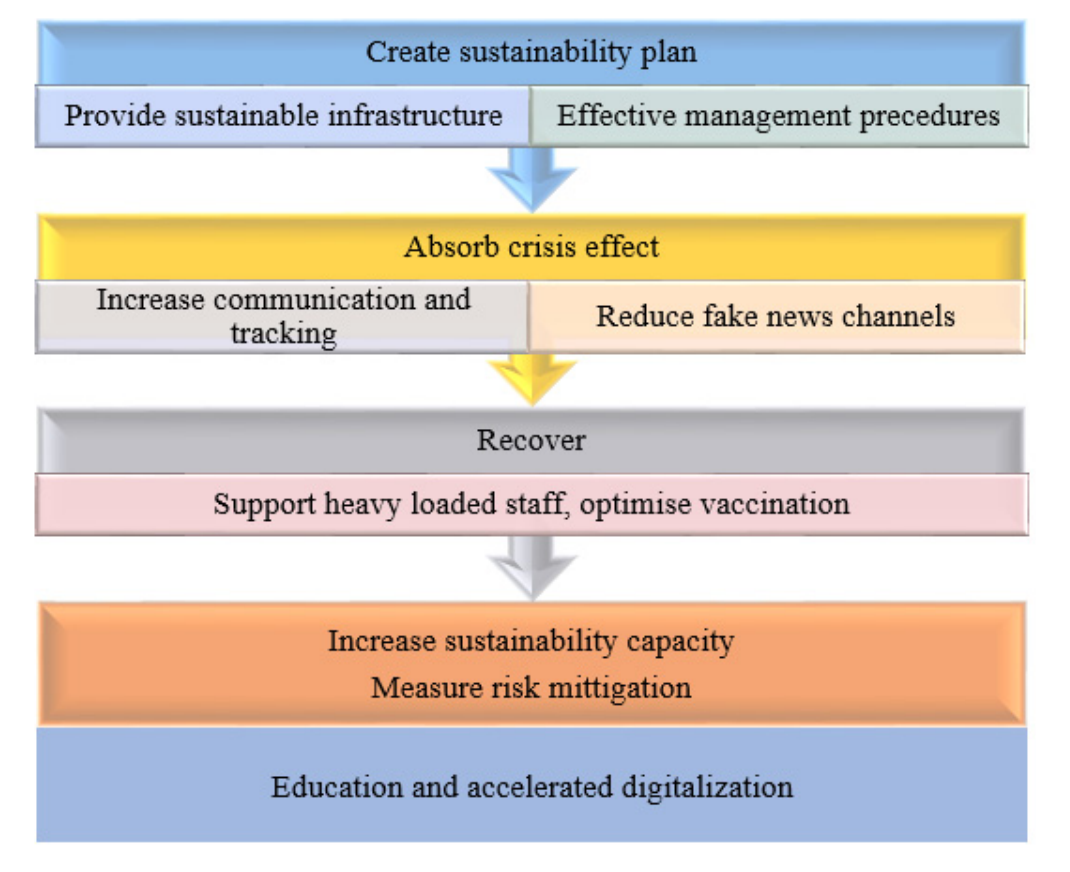
Figure 4. High levels of smart city risk-management model.